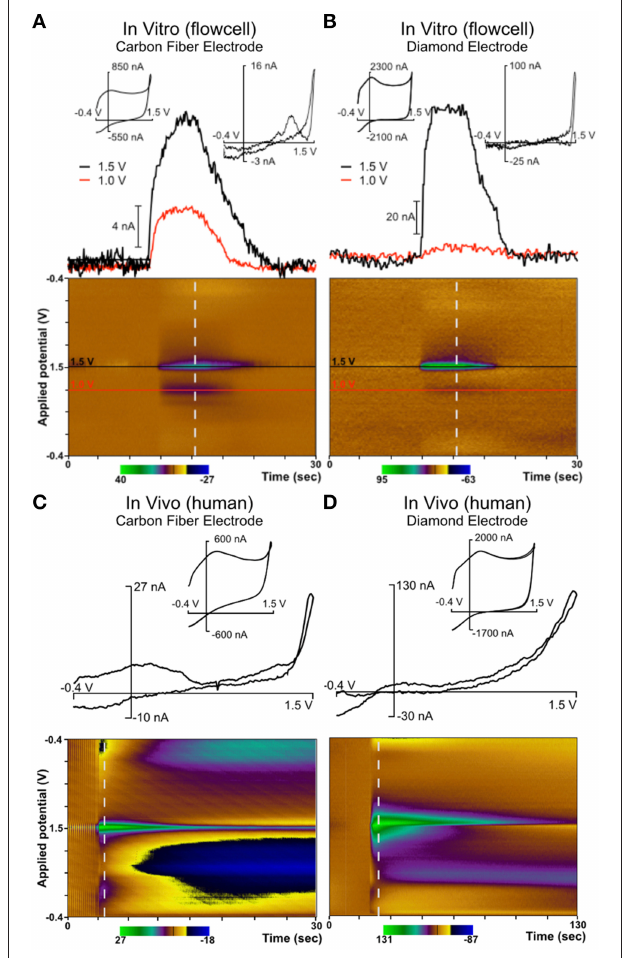
FIGURE 5 | Comparison of diamond electrode (the same electrode depicted in Figure 4) with a carbon fiber electrode in a flow cell and in vivo in the ventral intermediate (VIM) nucleus of the thalamus in a human patient. In both in vivo cases, neurotransmitter release was evoked by mechanical stimulation (“microthalamotomy” effect) and showed an adenosine-like signal. (A) Carbon fiber electrode in vitro ; (B) Diamond electrode in vitro ; (C) Carbon fiber electrode in vivo (human); (D) Diamond electrode in vivo